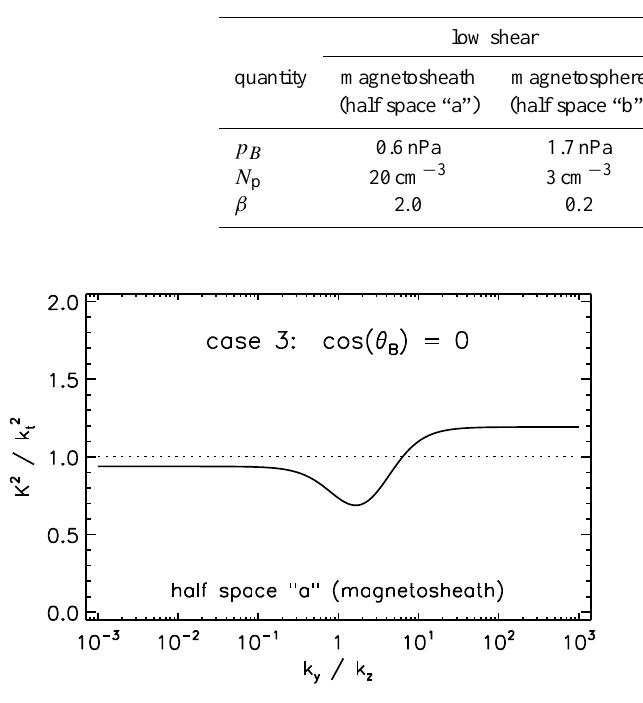
Fig. 3. Ratios K 2 /k 2 t = K 2 /(k 2 y + k 2 z ) of half space “a” (magne- tosheath) for different values of k y /k z and typical plasma condi- tions given in the text. Case 3 (cos θ B = 0) has been considered. For low ratios K 2 /k 2 t (cid:28) 1 the assumption of incompressibility would be